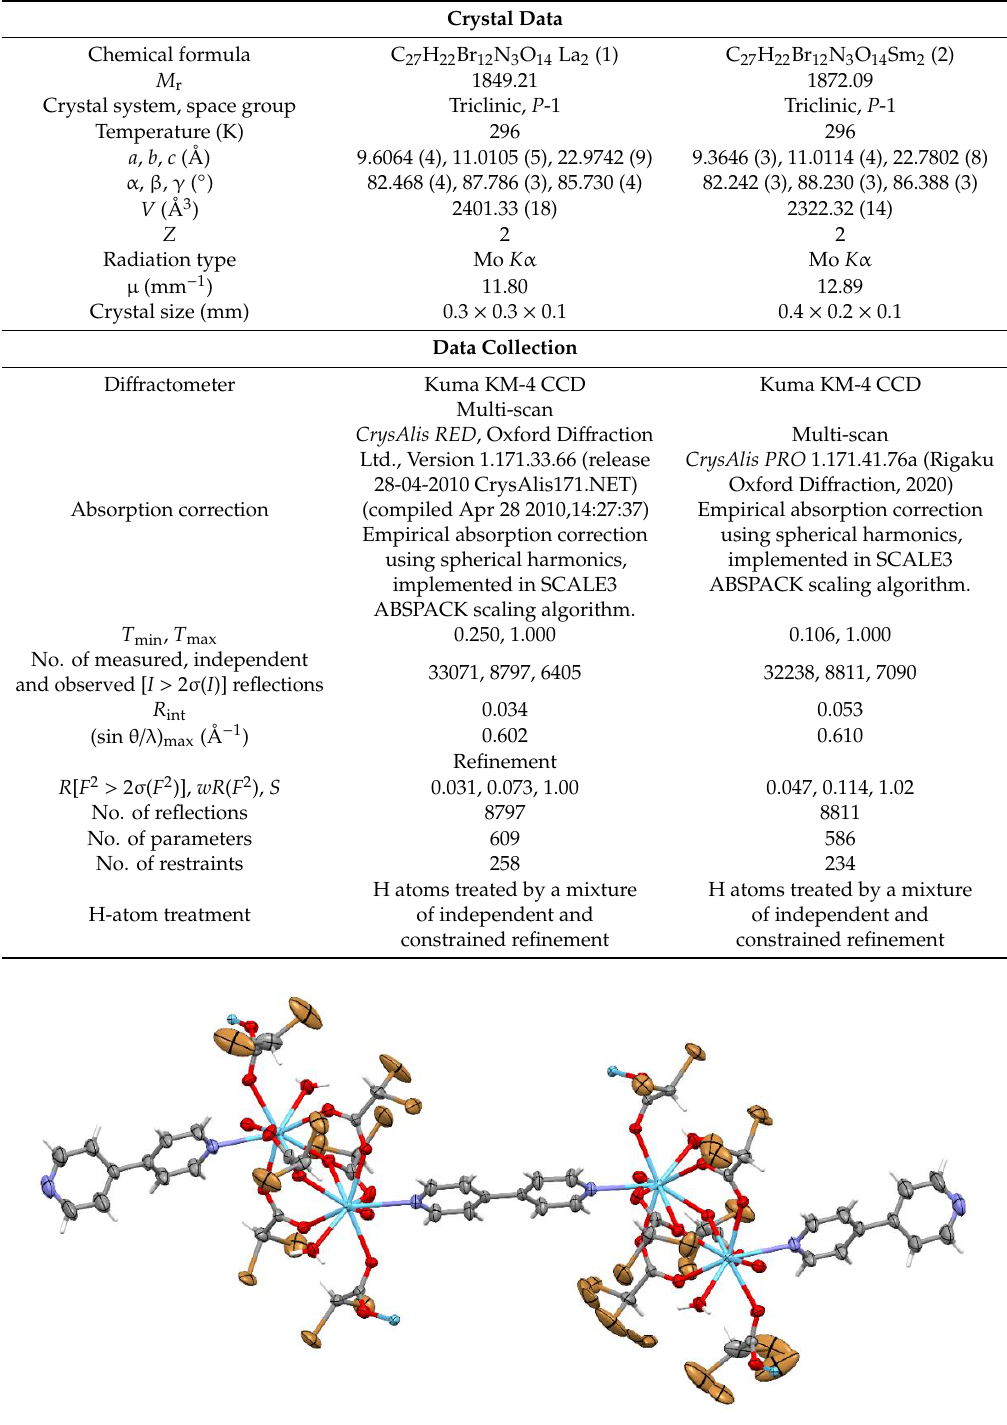
Figure 3. The molecular structure of complex with La(III) (compound 1), the displacement ellipsoids are drawn at the 50% probability level except H atoms.